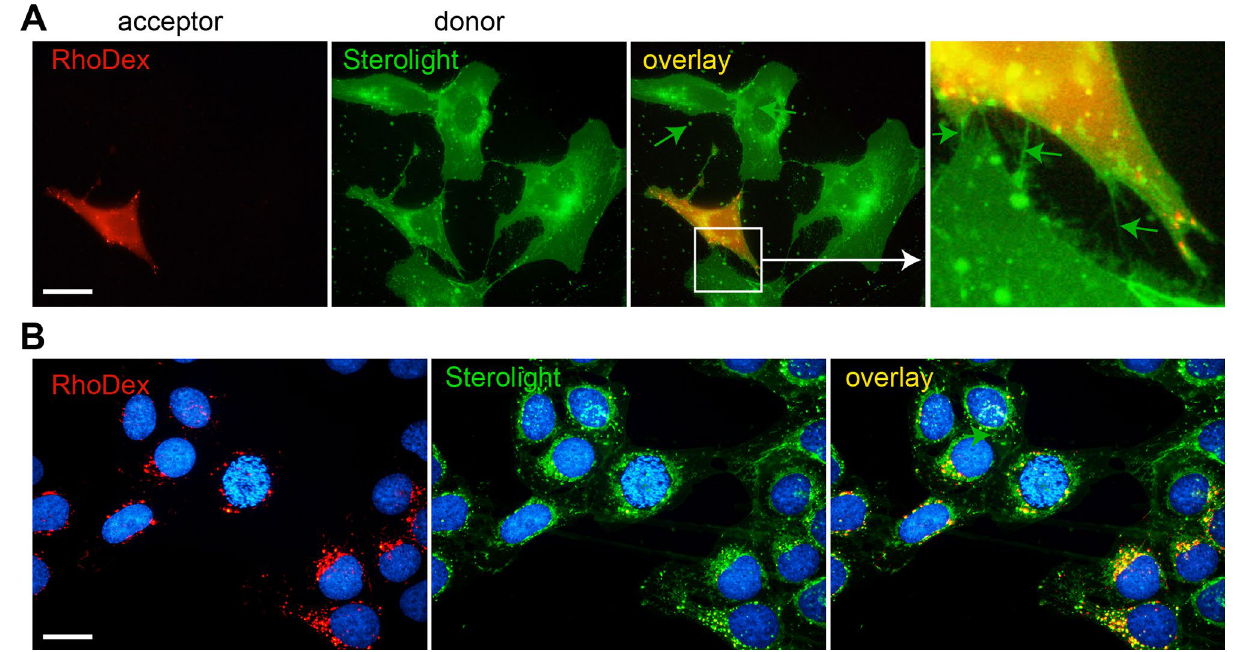
Figure 6. Sterolight transfer from donor to acceptor cells within one cell line. U-2 OS cells labelled overnight with rhodamine-dextran (RhoDex) (1 mg/ml) were harvested and plated on a dish with cells labelled with Sterolight probe via pulse. RhoDex and Sterolight labelled cells were further co-cultivated in FluoroBrite medium supplemented with 5% LPDS for 1 h ( A ) or 24 h ( B ). The fluorescence was recorded under